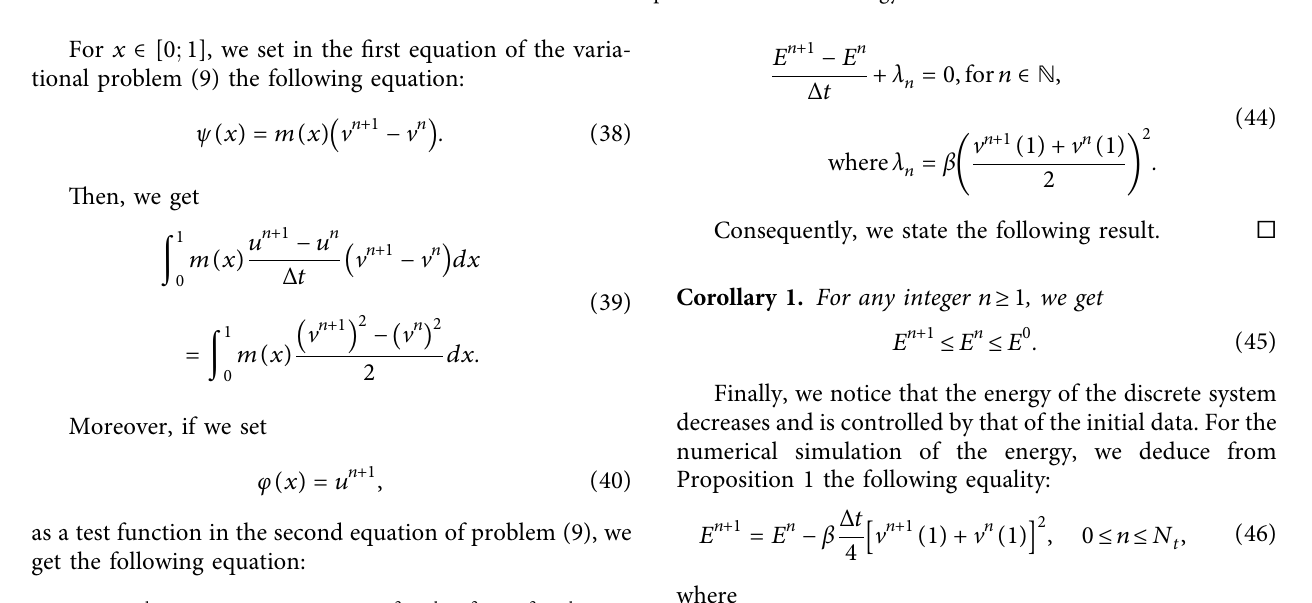
Figure 3: Influence of the parameter α on the